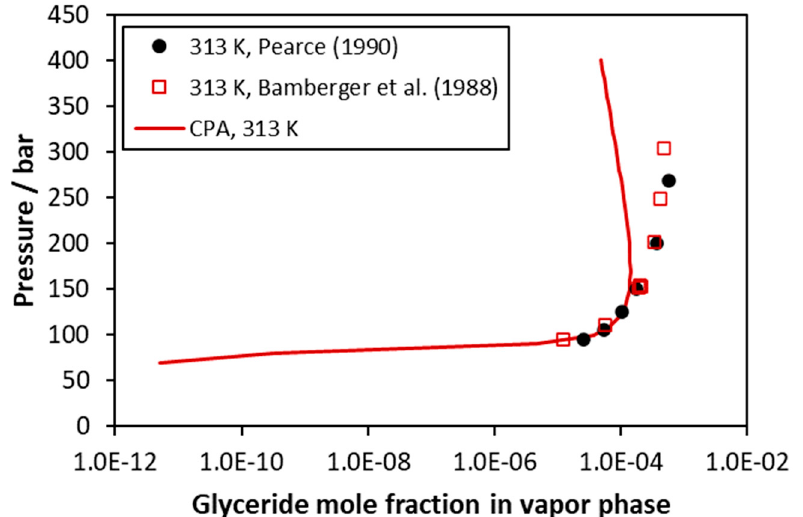
Figure 7. CO 2 –trimyristin VLE at 313 K (vapor phase compositions). Experimental data [46,48] and CPA correlations using the binary interaction parameter of Table 5.